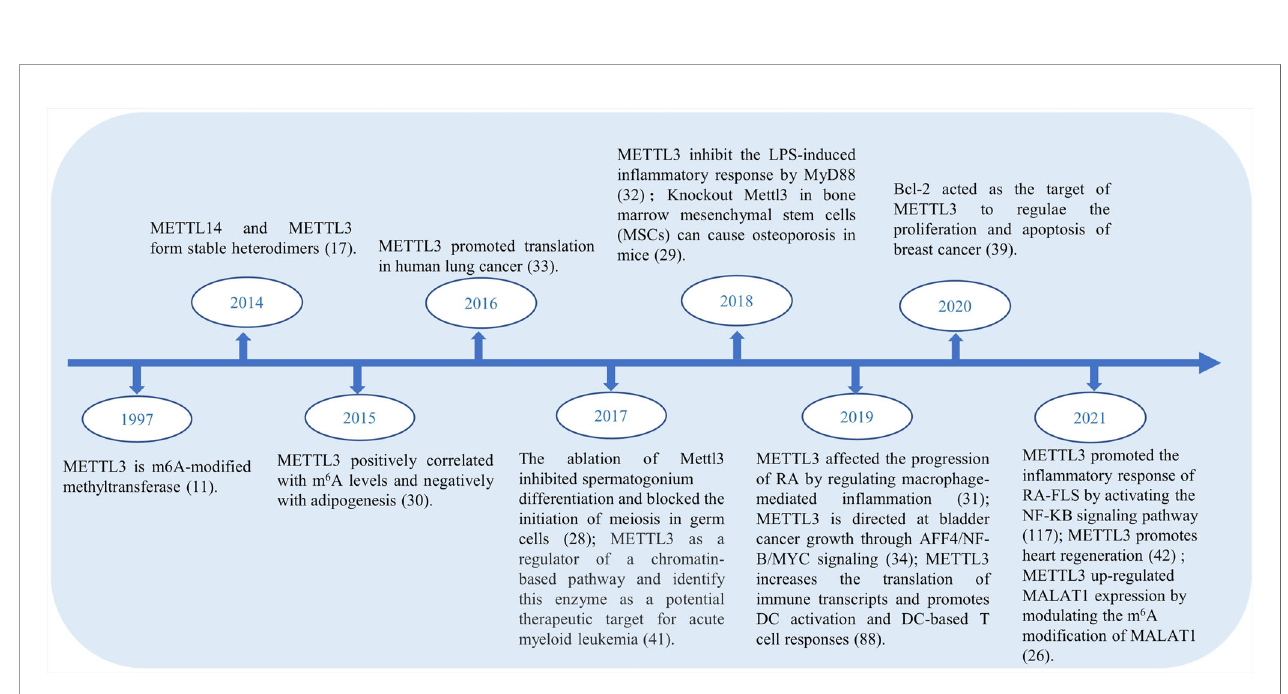
FIGURE 2 | Research progress on METTL3, which is one of the most studied genes in m6A